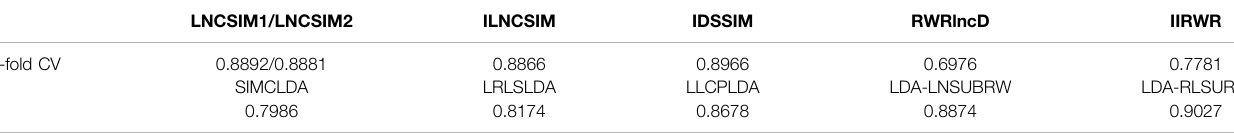
TABLE 1 | AUC values of LDA prediction methods on the lncRNADisease